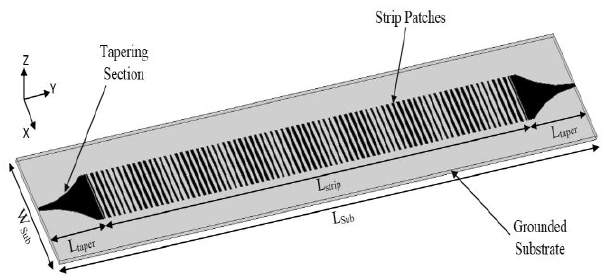
Figure 6: Geometry of the proposed sinusoidally modulated leaky wave antenna